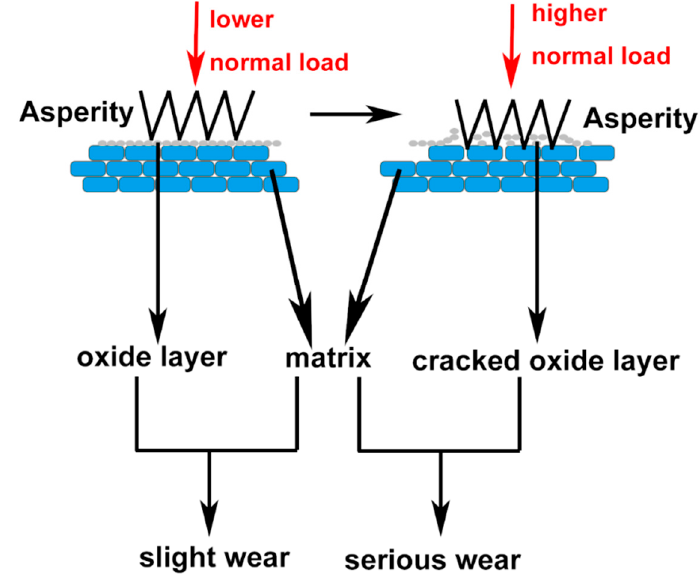
Figure 12. EDS analysis of region A in Figure 11b. Appl. Sci. 2018 , 8 , x FOR PEER REVIEW